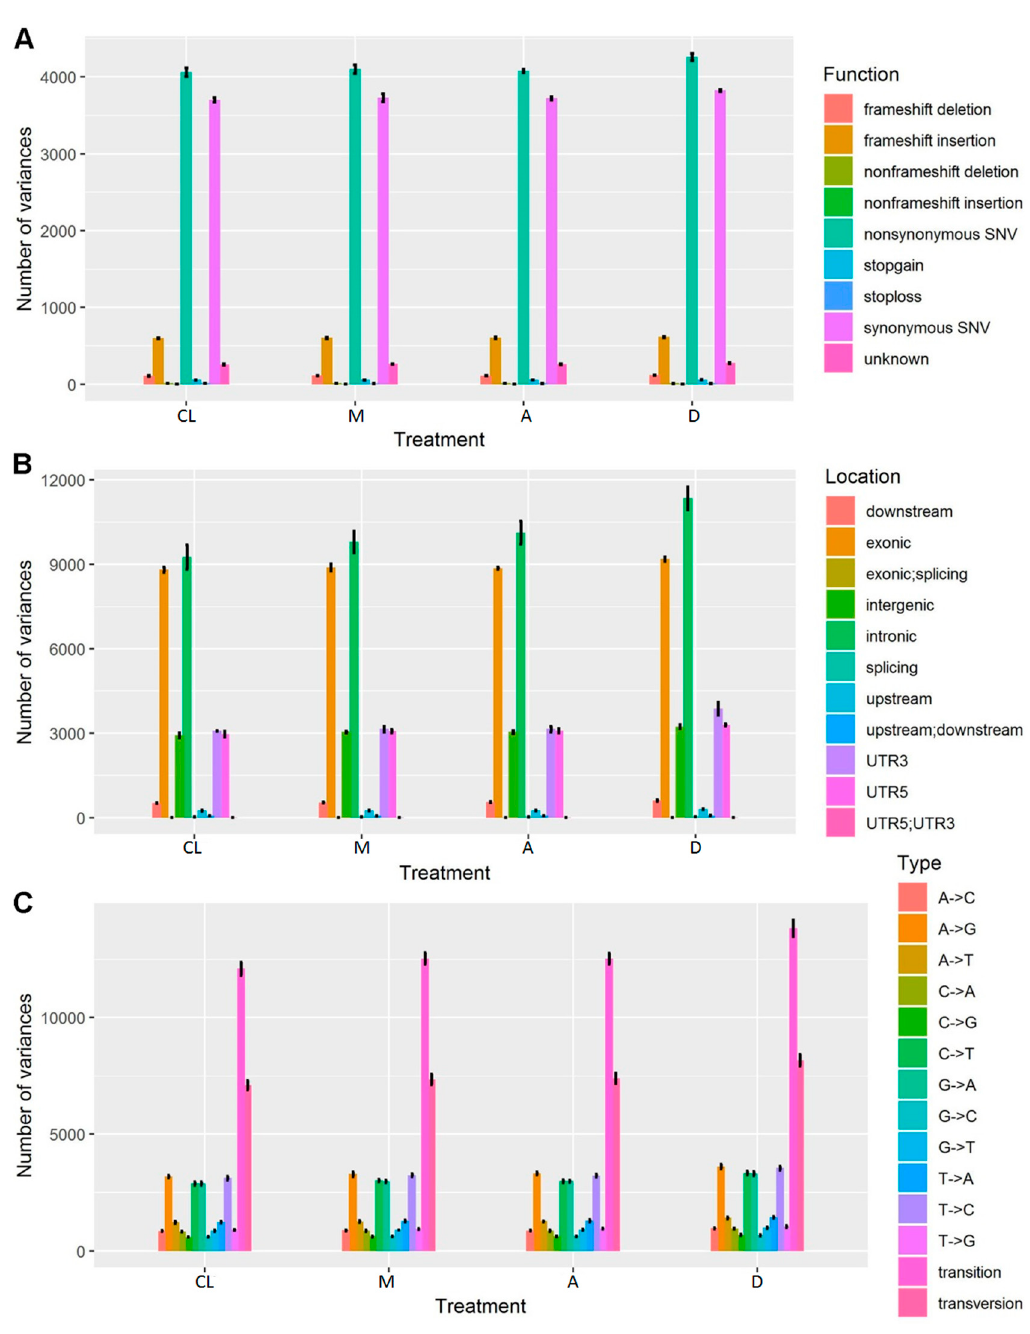
Figure 8. SNP/InDel Annotations in terms of function ( A ), location ( B ), and type ( C ). Figure 8. SNP / InDel Annotations in terms of function ( A ), location ( B ), and type ( C